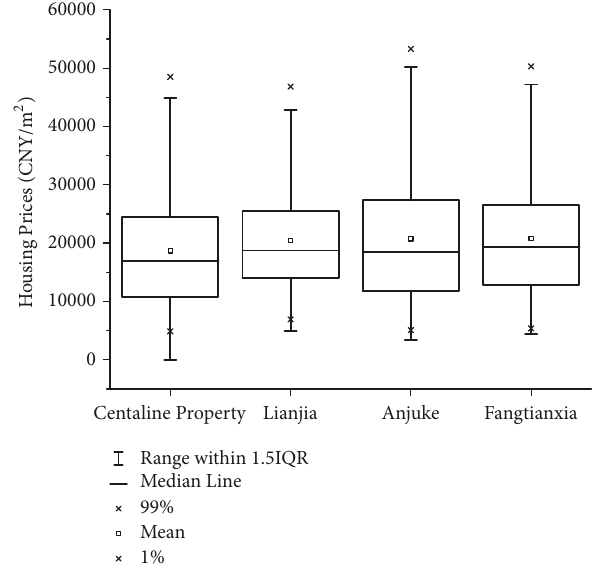
Figure 8: Statistical variations of second-hand neighbourhoods’ housing prices on for-profit real estate information platforms.